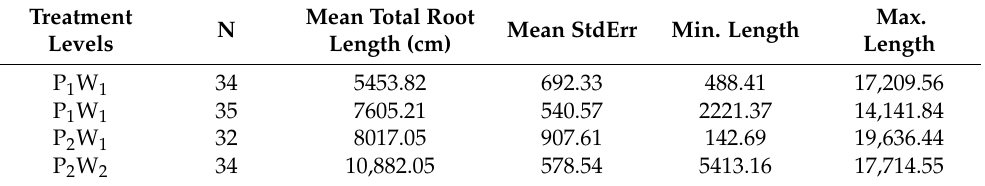
Table 10. Effect of phosphorus–water treatments on root-length of common bean.